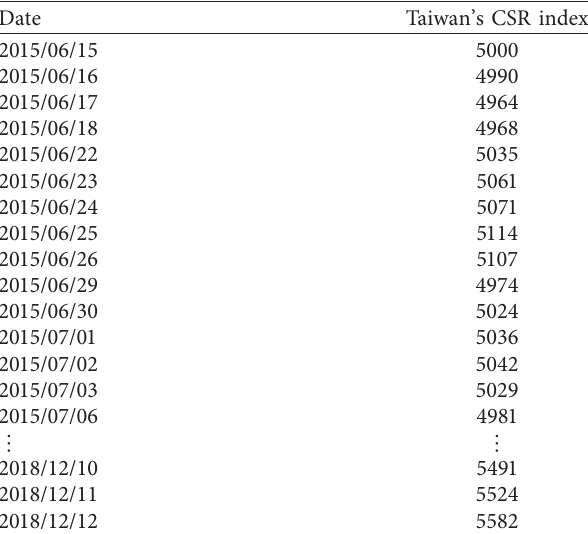
Table 1: Taiwan’s CSR index.